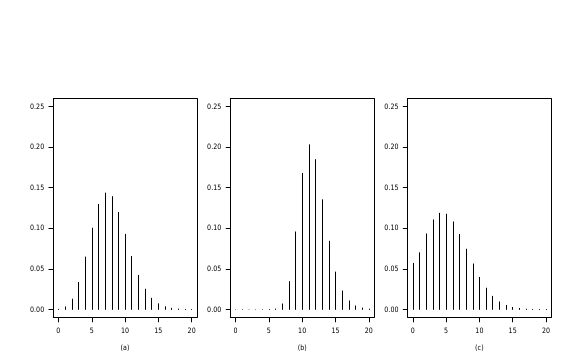
( θ ) } , in panel (a), where θ = 6.5.75, and power Figure 5 – An original Poisson distribution { p i ( θ , α ) } , for θ = 7.75 and α = 6.8, in panel (b), and for θ = 7.75 and Poisson distributions { r i α = 0.37, in panel (c).